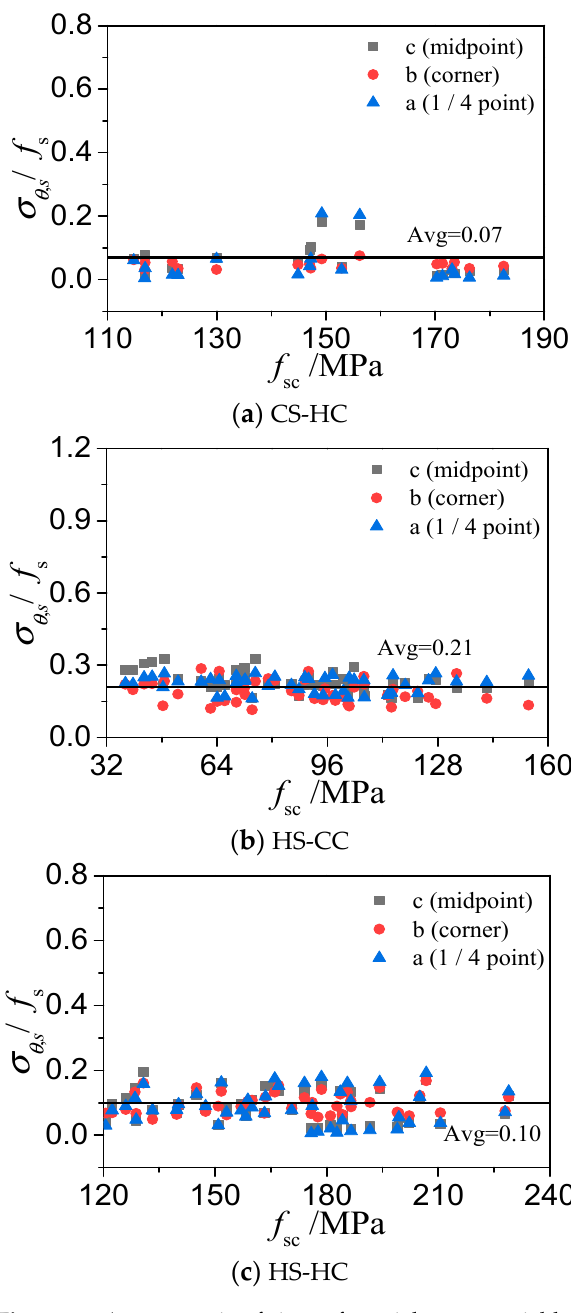
Figure 12. Average ratio of circumferential stress to yield strength of a high-strength steel tube.